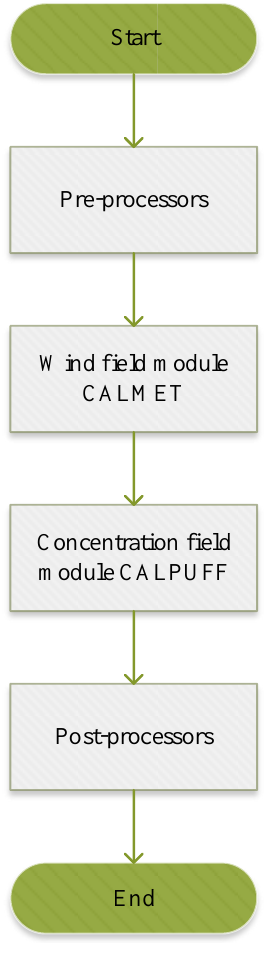
Figure 1. Flow chart of the CALPUFF model system.